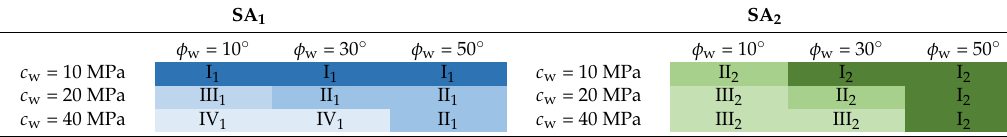
Table 6. Influence of cohesion and friction angle of weak planes on SA 1 , and SA 2 behaviors.